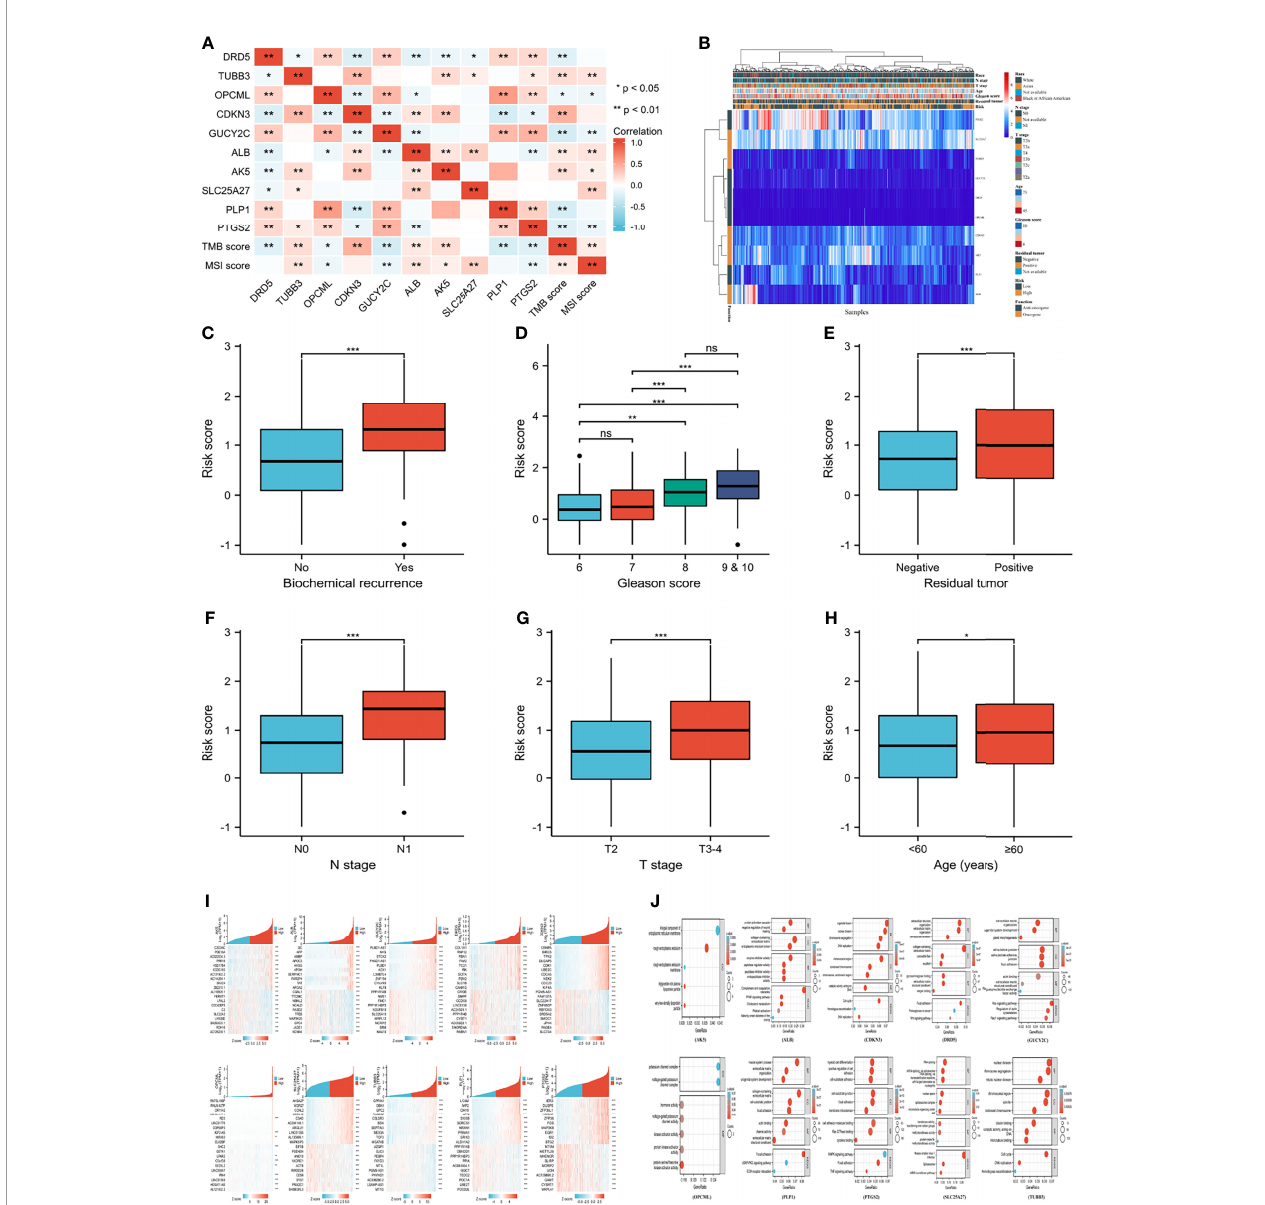
FIGURE 4 | Clinical correlation and function enrichment analysis. (A) correlation among genes, TMB score and MSI score; (B) the integrated heatmap showing correlation between genes and clinical parameters; (C) the correlation between biochemical recurrence and risk score; (D) the correlation between Gleason score and risk score; (E) the correlation between residual tumor and risk score; (F) the correlation between N stage and risk score; (G) the correlation between T stage and risk score; (H) the correlation between age and risk score; (I) the co-expressed genes of candidate genes; (J) the Gene ontology and Kyoto Encyclopedia of Genes and Genome analysis of enrolled genes. TMB, tumor mutation burden; MSI, microsatellite instability; BP, biological process; CC, cell composition; MF, molecular function. no signi fi cance (ns) means ≥ 0.05; ***means smaller than